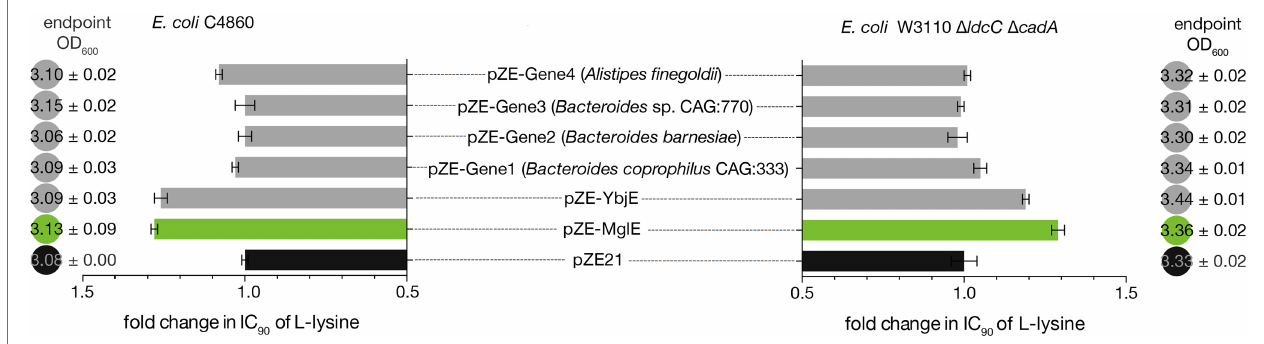
FIGURE 4 | Comparison of lysine tolerance (presented in relative IC90 values) displayed by MglE, YbjE (Lysine-specific exporter from E. coli ), and four synthetic MglE homologs. The biomass of the strains (at 24 h) cultured in LB media was also shown in closed